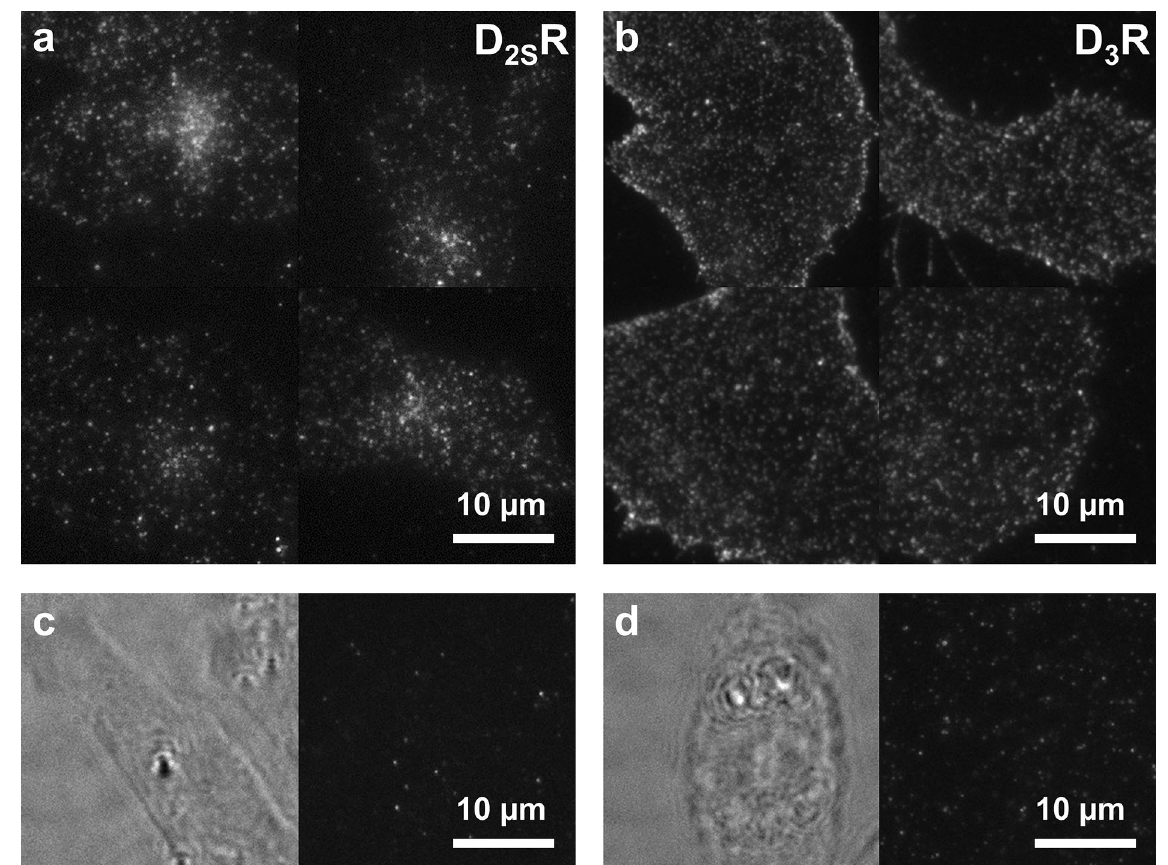
Figure 3. TIRF microscopy imaging with fluorescent ligand 10b . TIRF images of CHO cells stably expressing ( a ) D 2S R or ( b ) D 3 R labeled with 10b (10 nM for D 2S R, 1 nM for D 3 R) visualize the receptor distribution on the cell surface and demonstrate the suitability of the fluorescent ligand for high resolution fluorescence microscopy. ( c , d ) Validation of specific labeling: representative brightfield (left) and TIRF images (right) of a CHO cell stably expressing ( c ) D 2S R or ( d ) D 3 R, preincubated with the D 2/3 R antagonist spiperone (10 μM) and treated with 10b (10 nM) show only a few non-specifically adhered, immobile fluorescent spots and no cell-specific